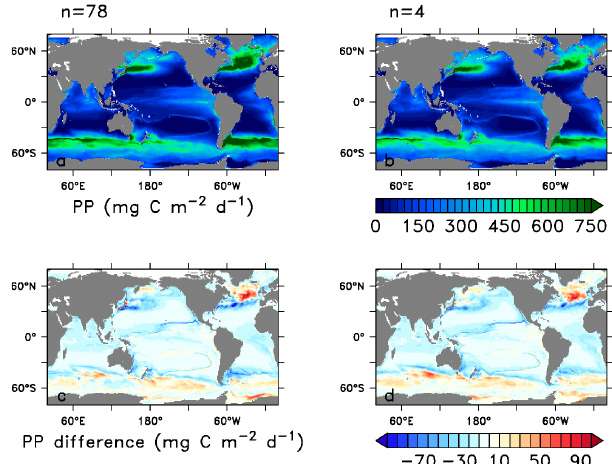
Figure 1. Primary production (PP; 0–100m) without reduced mix- ing (a, b) and difference in PP 10yr after mixing reduction (c, d) for the simulation with n = 78 phytoplankton subtypes (a, c) and with the four PFTs represented by one subtype each ( n = 4; b, d